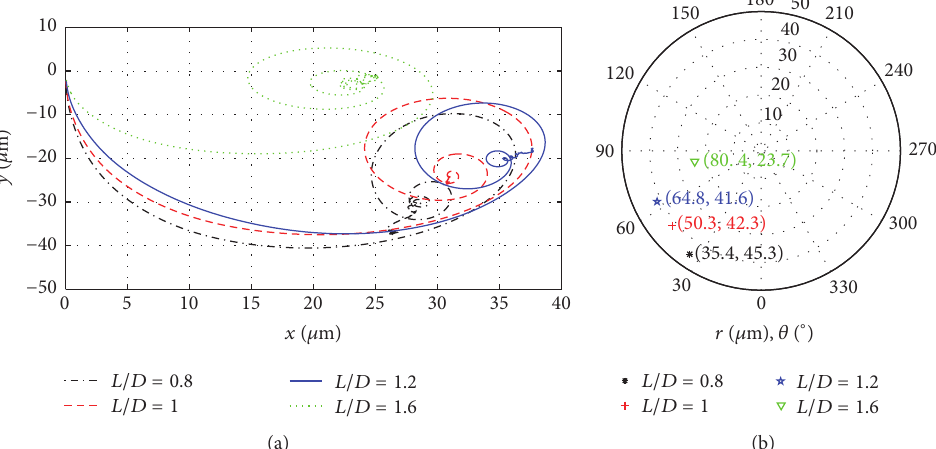
Figure 18: (a) Rotor trajectory and (b) polar coordinates of the HGGJB under different length to diameter ratio at the rotating speed of 10000 r/min.